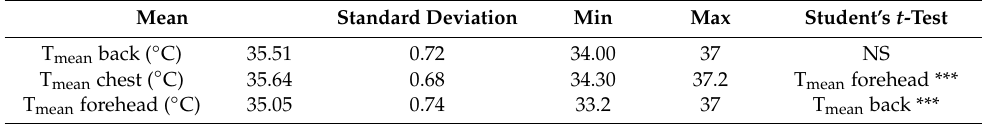
Table 2. Descriptive statistics of the T mean temperature values of newborns’ body areas under analysis. Mean